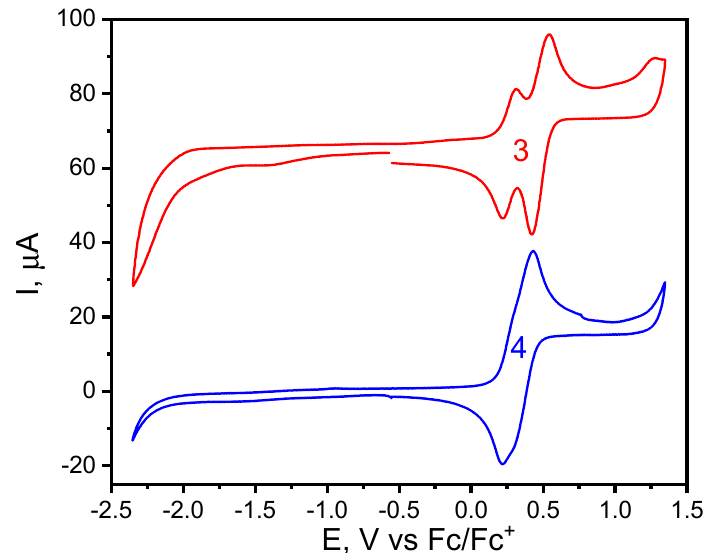
Figure 2. The cyclic voltammogram of biradical 3 and 4 in a dichloromethane solution, the scan rate was 0.1 V·s –1 , and Bu 4 NPF 6 (0.1 M) was used as a supporting electrolyte. The data for biradical 3